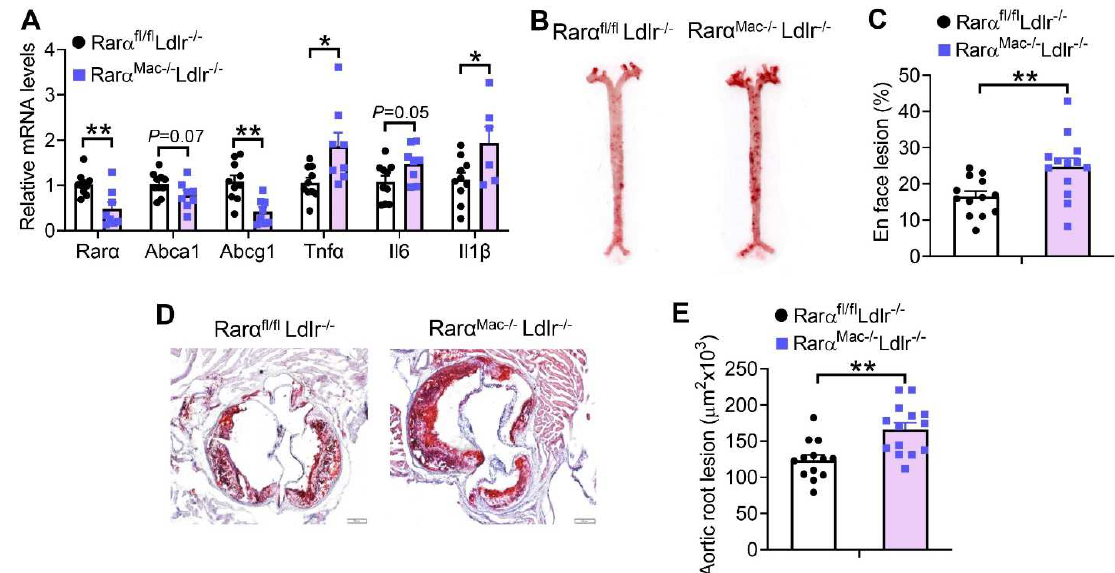
Figure 5. Loss of RAR α in macrophages promotes the development of atherosclerosis in Ldlr -/- mice. Rar α fl/fl Ldlr -/- and Rar α Mac-/- Ldlr -/- mice were fed a Western diet for 16 weeks. The mRNA levels of genes in the plaques of aortic roots were quantified ( A ) ( n = 8–10). Representative images ( B ) and plaque size ( C ) of en face aortas as well as representative images ( D ) and plaque size ( E ) of aortic roots are shown ( n = 13–16). In ( A , C , E ), unpaired two-tailed Students’ t -test was used for statistical analysis. All the data are expressed as mean ± SEM. In ( D ), scale bar = 1 mm. * p < 0.05, ** p <